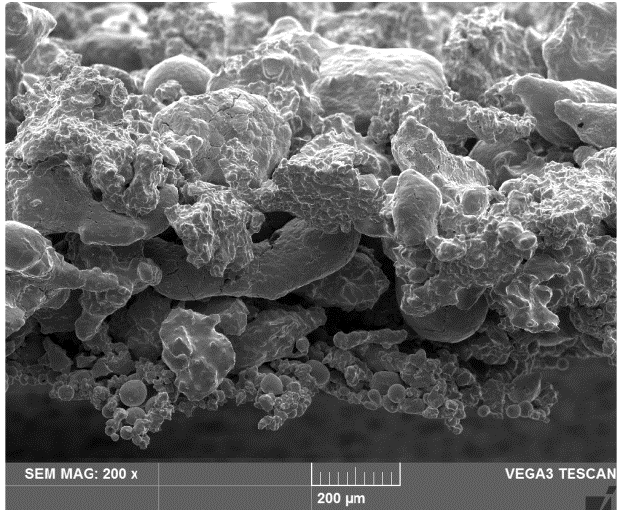
Figure 5. Fractography of the filter.